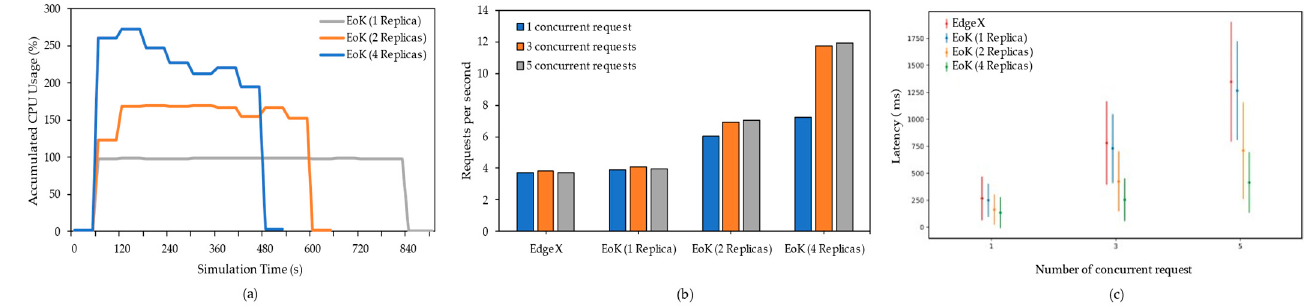
Figure 7. Performance of EoK with HPA: ( a ) average CPU usage of each replica set, ( b ) throughput, and ( c ) latency. Figure 7 evaluates the average CPU usage according to the number of pods, through- 435